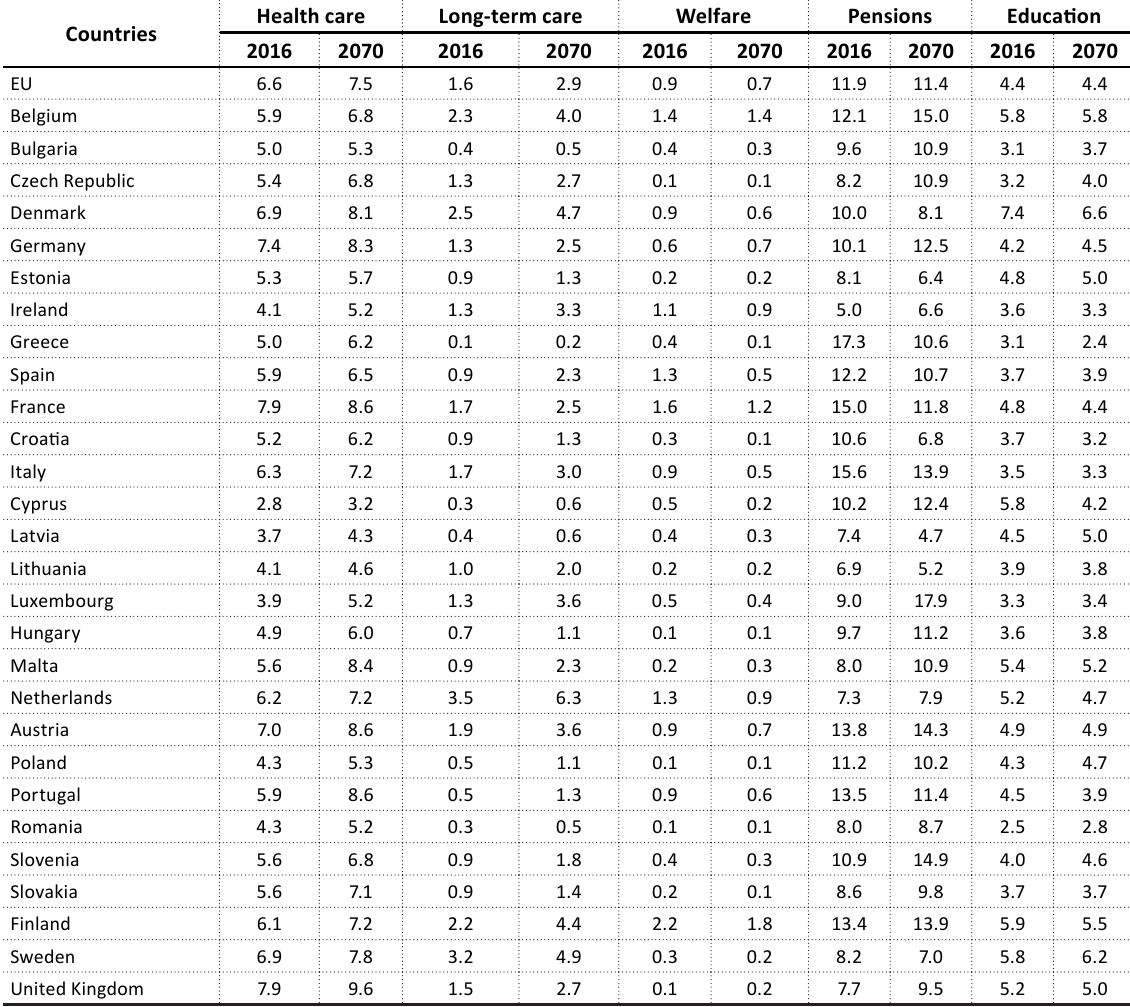
Table 3. Projected increase in the share of government expenditures in GDP, % Source: Compiled based on data from European Commission